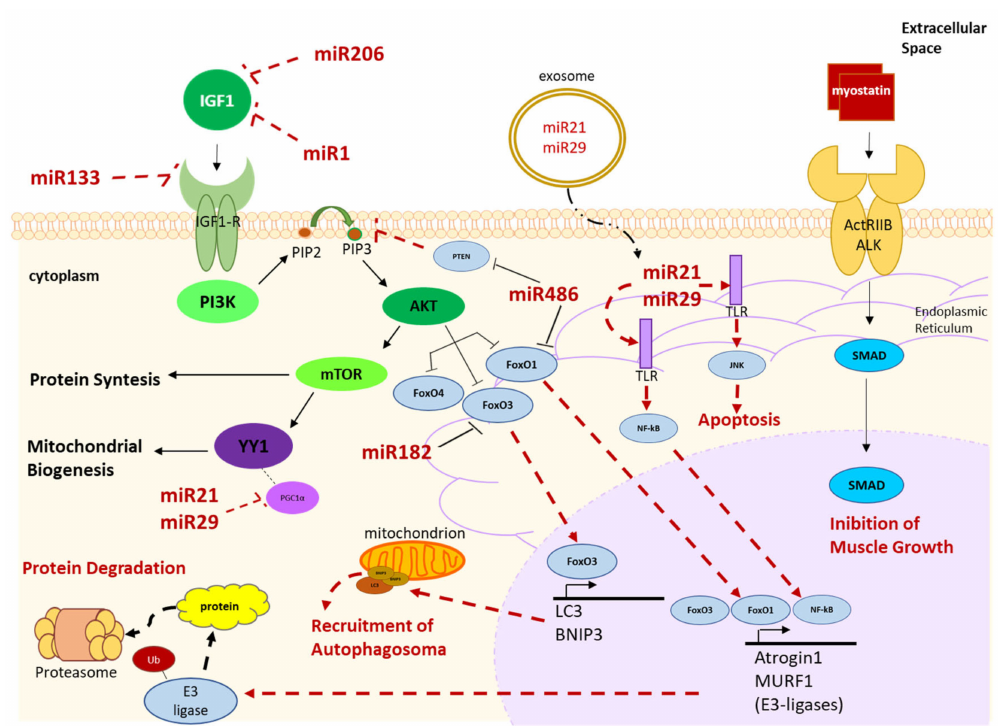
Figure 3. Schematic representation of miRNAs involved in the regulation of atrophy and protein degradation pathways in skeletal muscle tissue. Insulin-like growth factor 1 (IGF-1) activates the Akt/mTOR signaling pathway, responsible for protein synthesis. Akt inhibits the degradation of proteins by keeping inactive in the cytoplasm transcription factors members of the forkhead box protein O (FoxO) family (FoxO1, FoxO3 and FoxO4), which otherwise migrate in the nucleus and promote the transcription of the E3 ligases (Atrogin1 and MuRF1), responsible for the protein degradation mediated by the system of the ubiquitin proteasome. In the nucleus FoxO3 is also able to promote the transcription of microtubule- associated protein 1A/1B-light chain 3 (LC3) and BCL2 Interacting Protein 3 (BNIP3) which once in the cytoplasm localize on the outer membrane of the mitochondria, promoting mitophagy through the recruitment of the autophagosome. The Akt/mTOR pathway is also able to promote the activation of the factor Yin Yang 1 (YY1) which, associating with peroxisome proliferator activated receptor gamma coactivator 1 alpha (PGC1 α ), induces mitochondrial biogenesis. Akt activation is inhibited by phosphatase and tensin homolog (PTEN) which inhibits the phosphorylation of PIP2 to PIP3. Several in vitro and in vivo studies have shown that elevated circulating levels of miR-1, miR-133a/b and miR-206 appear to negatively regulate the IGF-1/Akt/mTOR pathway, by targeting positive regulators IGF-1 and IGF1-receptor (IGF-1R) thus promoting muscle wasting. On the contrary, miR-486 and miR-182 promote protein synthesis, by targeting negative regulators of this signaling pathway (PTEN, FoxO1-3). miR-21 and miR-29 contained in the exosomes can penetrate the muscle fiber and activating the TLR7/8 located on the endoplasmic reticulum promoting i) the activation of JNK which induces apoptosis of the muscle fiber and ii) NF-kB which, migrating in the nucleus, promotes the transcription of Atrogin1 and MuRF1, responsible for protein degradation. miR21 and miR29 in skeletal muscle tissue are also able to negatively regulate mitochondrial biogenesis by targeting YY1. Finally, the signaling pathway induced by myostatin activates SMADs (2-3-4) which, by moving to the nucleus, inhibit muscle growth. Dashed arrows indicate the pathways that lead to muscle wasting. Dashed lines indicate the inhibitory function of miRNAs in skeletal muscle tissue. Black arrows indicate the pathways involved in muscle